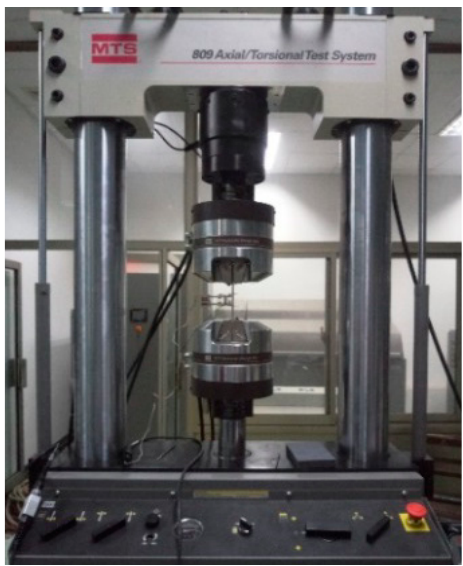
Figure 2. The electro-hydraulic universal testing machine MTS.